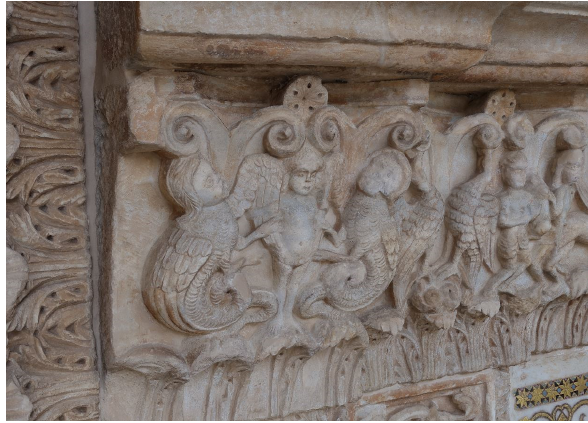
Figure 14. 3D model of the capital